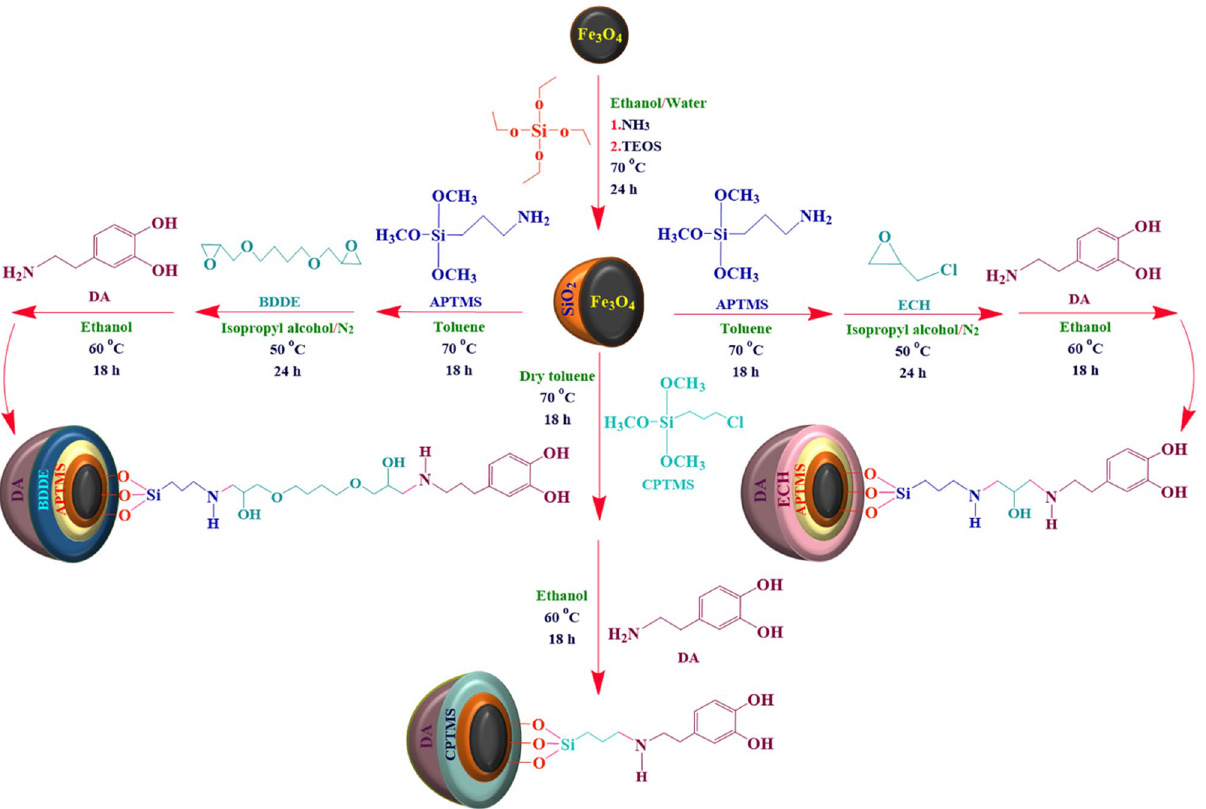
Figure 1. Schematic illustration of novel magnetic nanocomposites by modifying surface of Fe 3 O 4